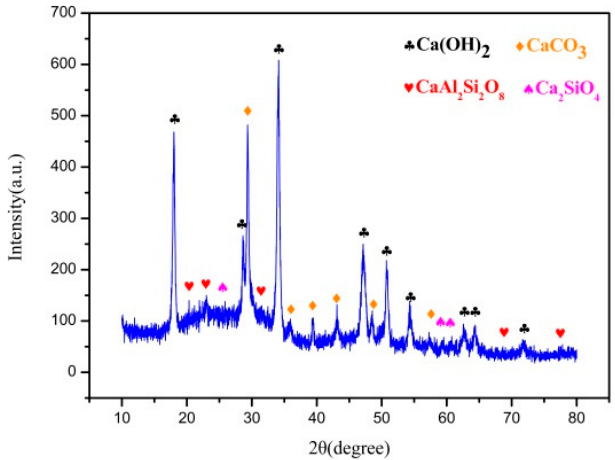
Figure 5. XRD pattern of modified absorbent.